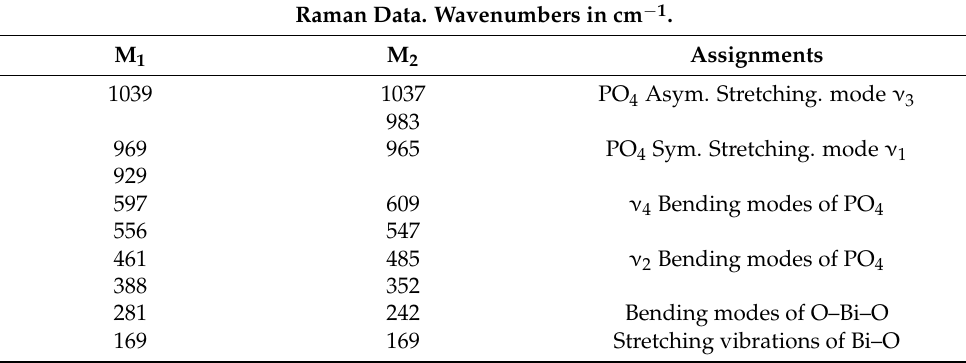
Table 4. Raman spectroscopy data and assignments of vibration bands for the monoclinic phases of BiPO 4